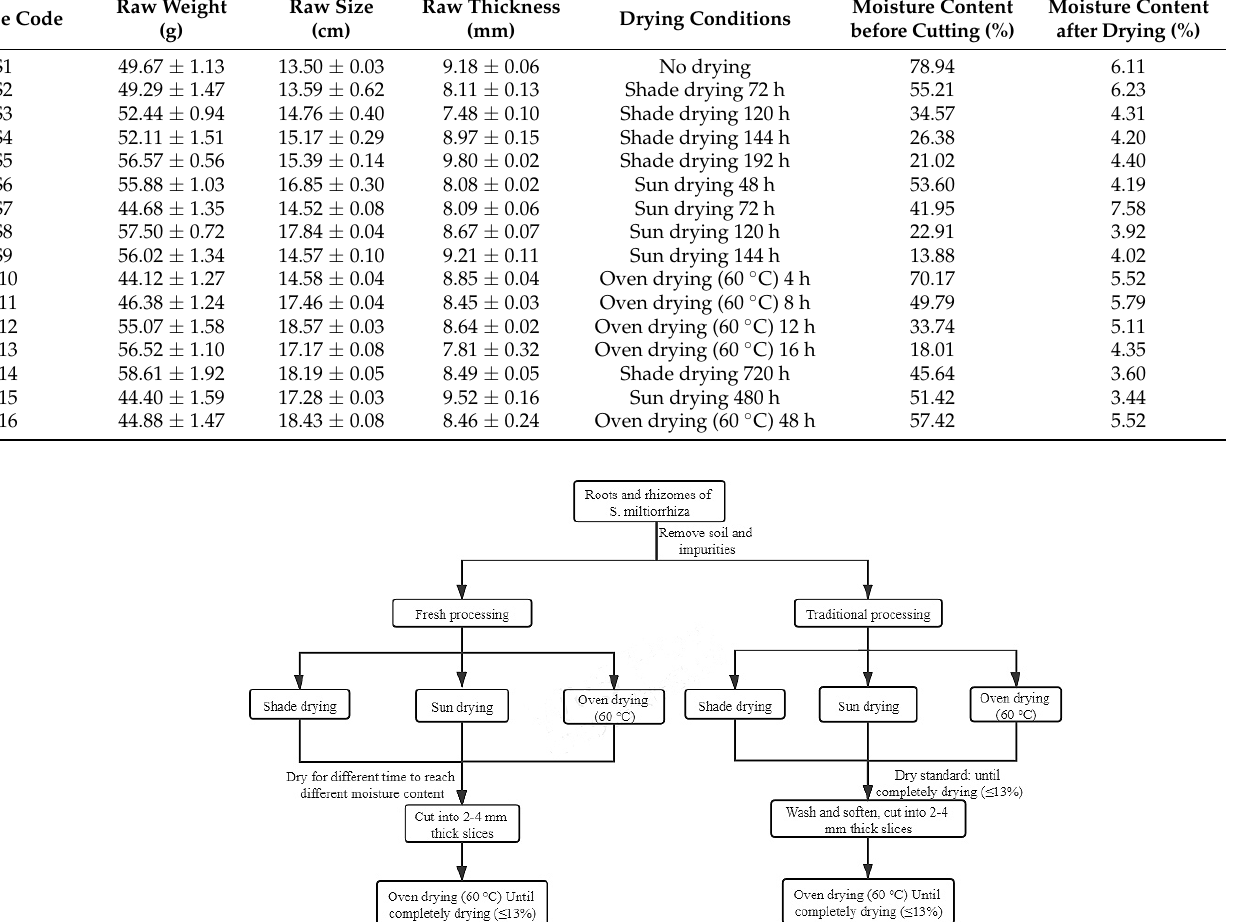
Figure 8. The process flow of S. miltiorrhiza roots and